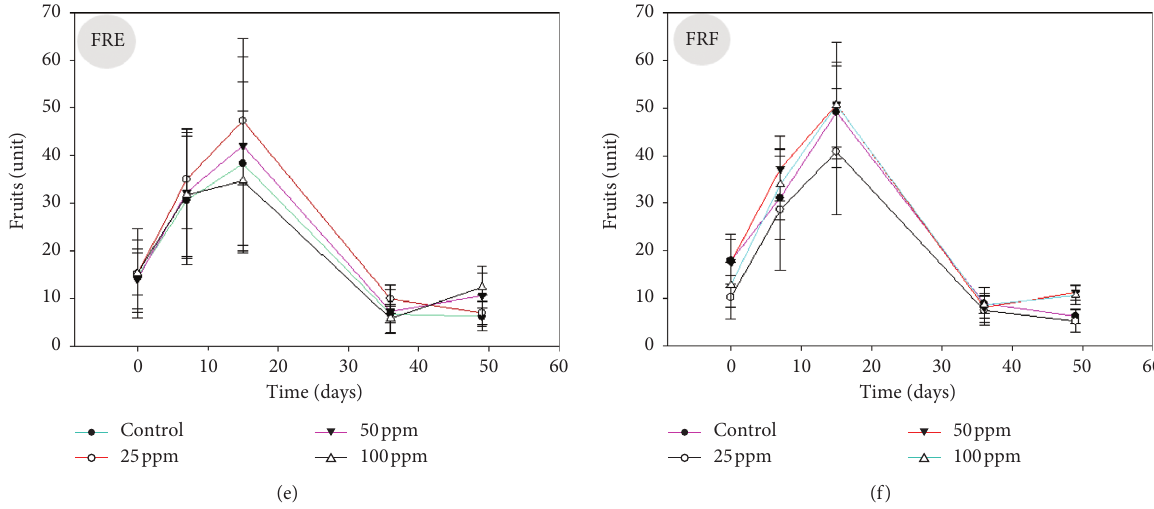
Figure 4: Evaluation of morphometric variables of the effect of ZnO phytonanoparticles with the Moringa oleifera extract on the tomato plants ( Solanum lycopersicum ). Mean of three repetitions with standard error. HE: height/edaphic; HF: height/foliar; FE: flowering/edaphic; FF: flowering/foliar; FRE: fruiting/edaphic; FRF: fruiting/foliar. Table 1: Percentage analysis of the increase or decrease of the morphometric variables, accumulation of elements, and total soluble solids, depending on the effect of phytonanoparticles on tomato plants and fruits ( Solanum lycopersicum ). Flowering